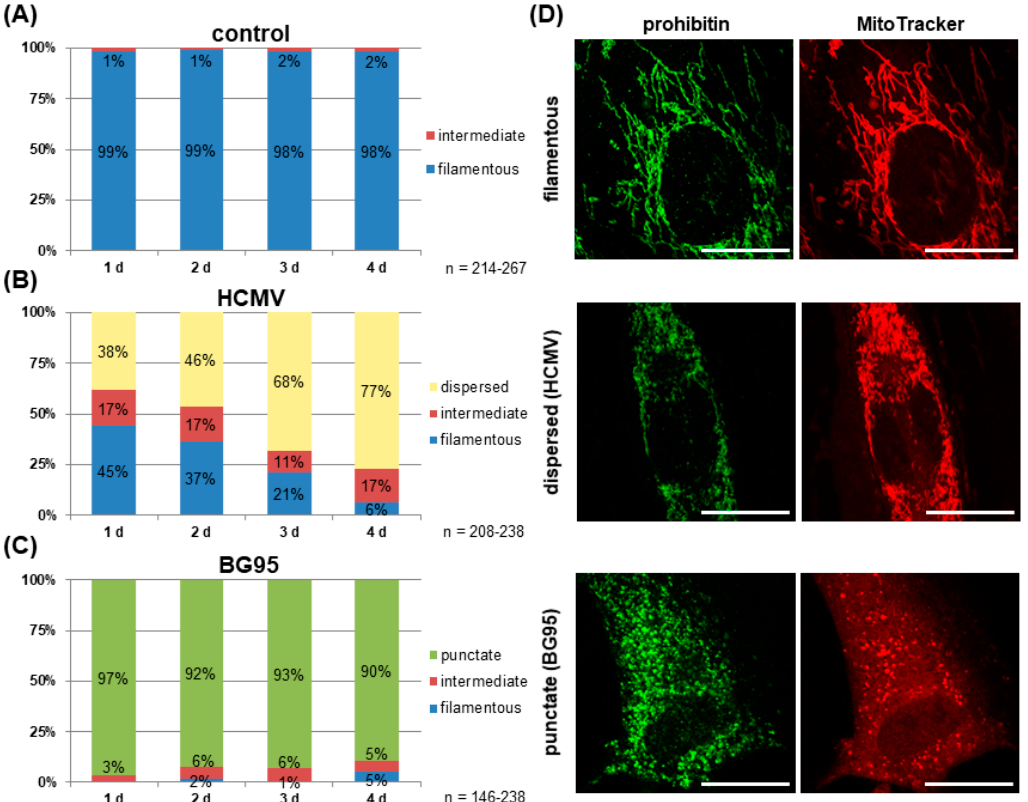
Figure 3. BG95 treatment and HCMV infection induce distinct changes in mitochondrial morphology, i.e., punctate or dispersed patterns, respectively. The mitochondrial architecture was assessed using confocal microscopy and both prohibitin and MitoTracker staining and was classified into four categories based on visual monitoring and cell counting, i.e., filamentous / normal, dispersed (HCMV), punctate (BG95) and intermediate. Cells were fixed and examined at four consecutive days after infection with the beginning of treatment as indicated. ( A ) Mitochondria of mock-infected, untreated HFFs showed a filamentous structure, which did not change over time. ( B ) Infection with HCMV AD169 led to mitochondrial fragmentation towards a dispersed phenotype, which increased over time in correlation to virus production and spread. ( C ) BG95 treatment of HFFs (10 µ M) induced an invariable punctate architecture in mitochondria in the vast majority of cells. ( D ) Representative pictures illustrating the changes of mitochondrial morphology quantitated in A–C. Scale bars represent 20 µm.